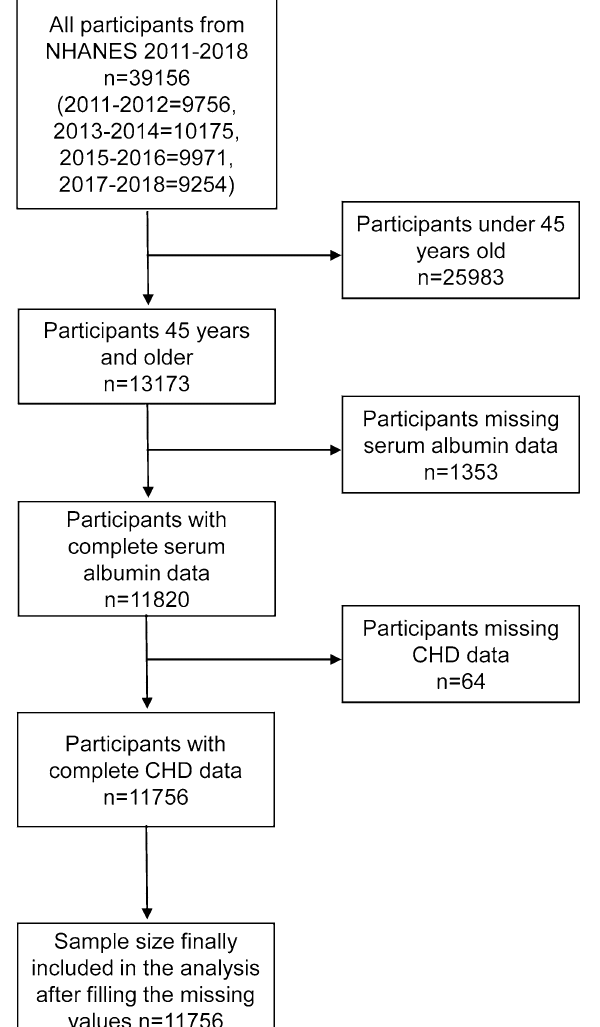
Figure 1. Participant screening flow